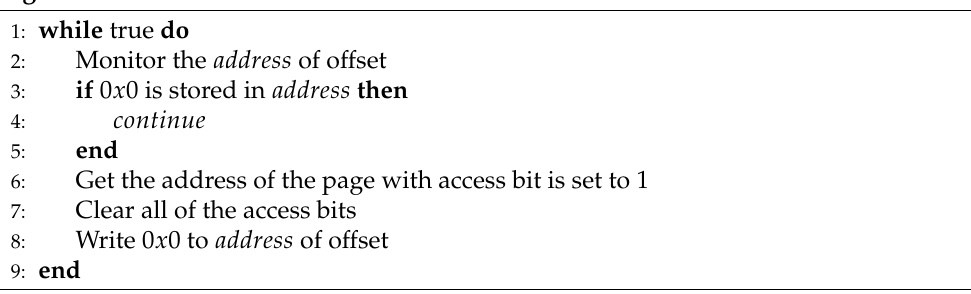
Algorithm 2 Flow of Kernel